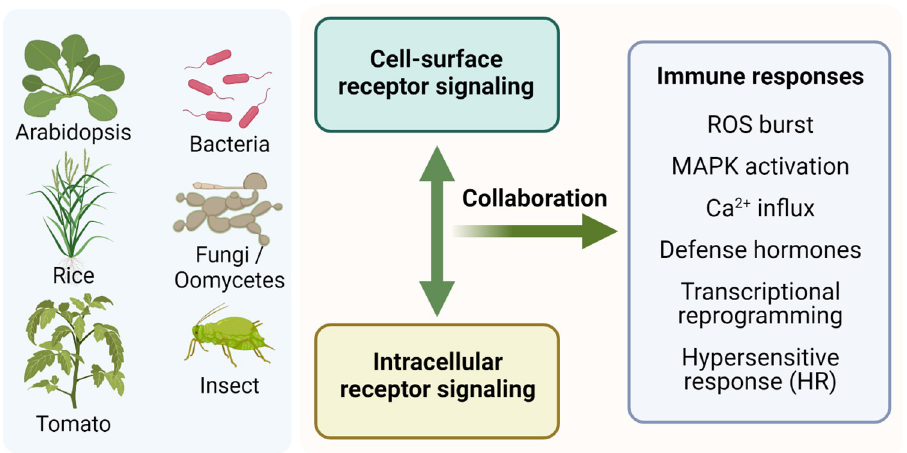
Fig 2. Conservation of synergies between cell-surface and intracellular receptor-mediated signaling in different plant pathosystems. Studies suggest a similar mode of synergistic interactions between cell surface and intracellular receptor pathways in some other plant species, but different forms of interplay between the two pathways may also exist. More studies are needed in the future to get a clear and full picture of plant immune networks in diverse species. Created with